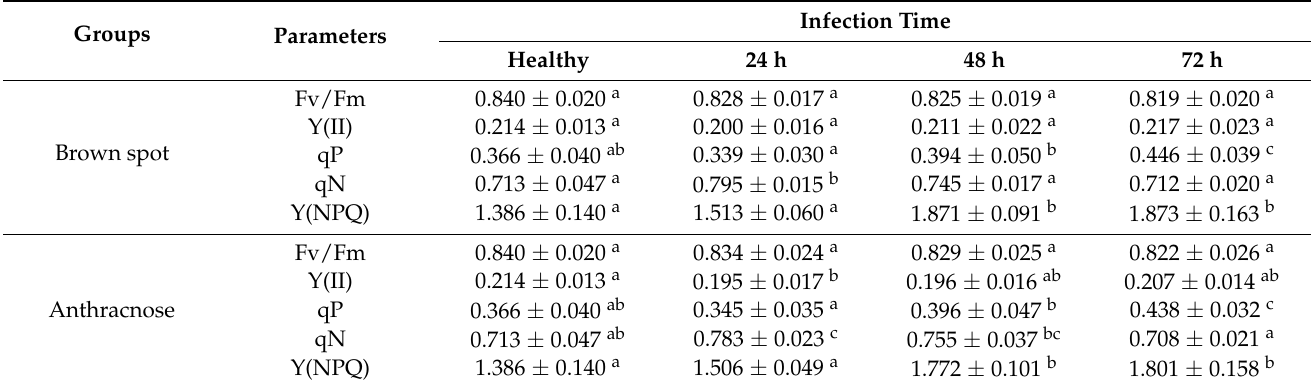
Table 2. Effects of fungal infection on mean and standard error of the chlorophyll fluorescence parameters for the cucumber’s